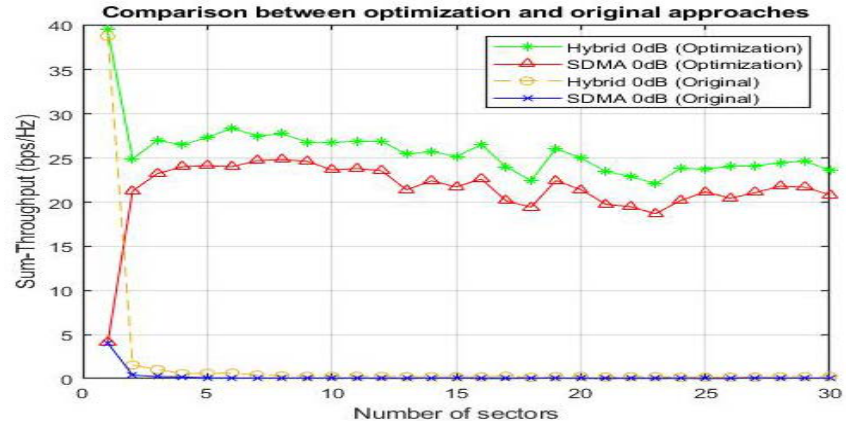
Figure 6. Sum throughput: comparison between optimization and original